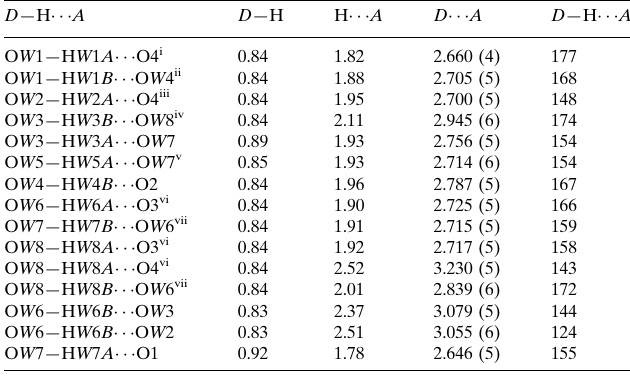
Bruker SMART diffractometer Absorption correction: multi-scan ( SADABS ; Bruker, 1998) T min = 0.762, T max = 0.839